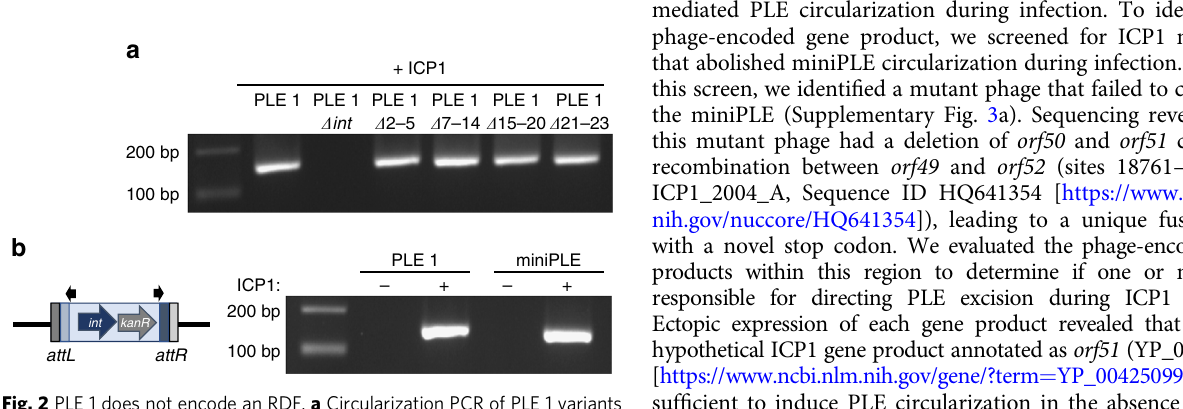
Fig. 2 PLE 1 does not encode an RDF. a Circularization PCR of PLE 1 variants lacking ORFs as indicated, taken 5 min after infection by ICP1 at an MOI of 5. b Cartoon of the miniPLE (left) containing PLE 1 int and a kanamycin cassette ( kanR ) integrated into the V. cholerae chromosome in the same location as PLE 1 with the same att sites. Circularization of miniPLE (right) can be detected 5min post ICP1 infection using the same primers as used for PLE 1 circularization. Uncropped gels are presented in Supplementary Fig.